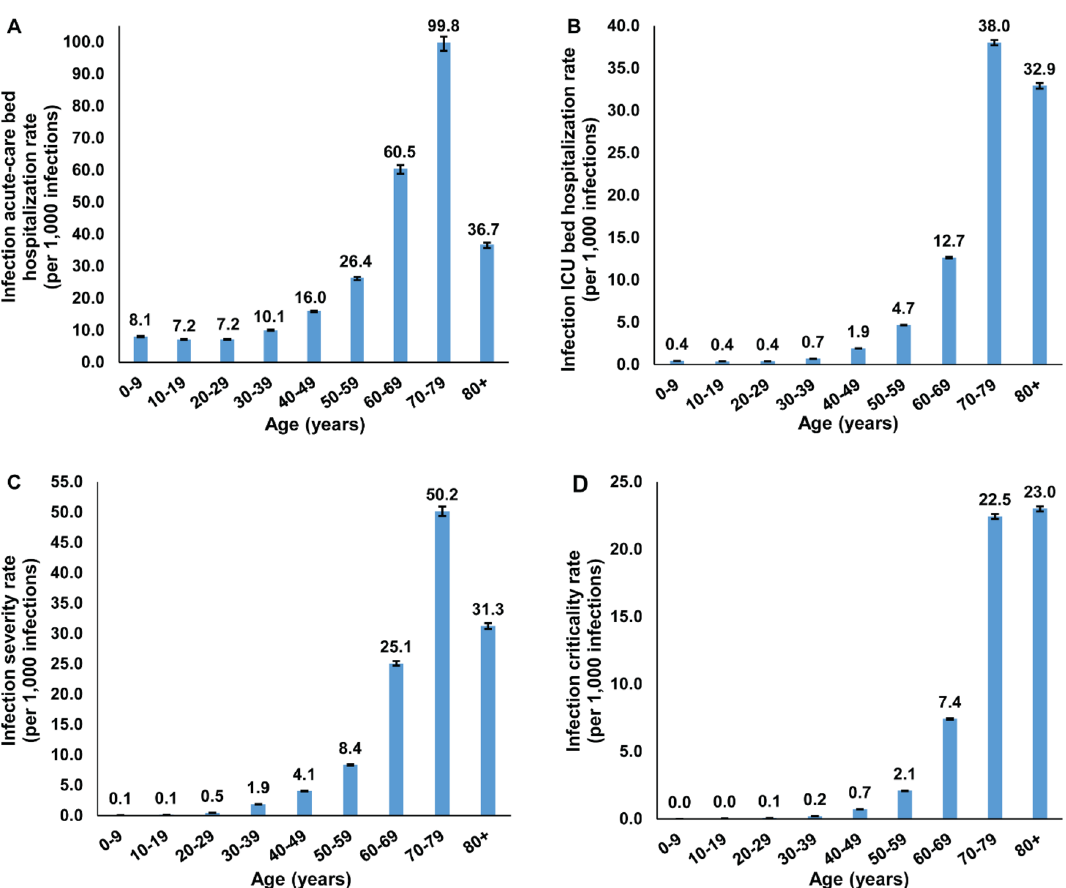
Figure 2. The age-specific ( A ) infection acute-care bed hospitalization rate, ( B ) infection ICU bed hospitalization rate, ( C ) infection severity rate, and ( D ) infection criticality rate. Classification of infection severity and criticality was per WHO severity classification 11